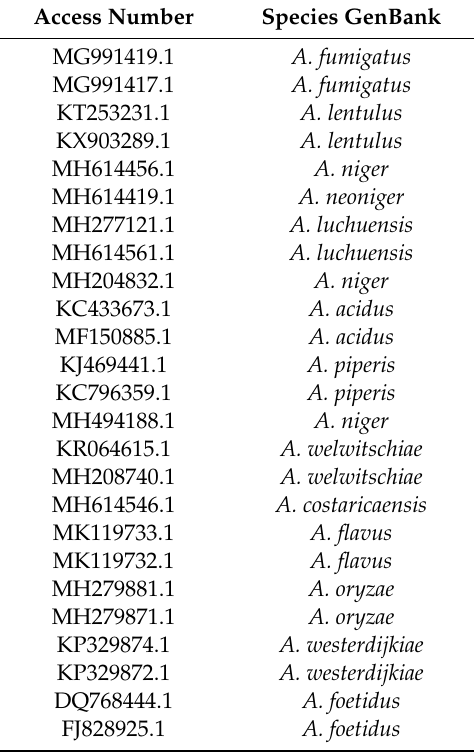
Table 2. Reference sequences corresponding to the benA